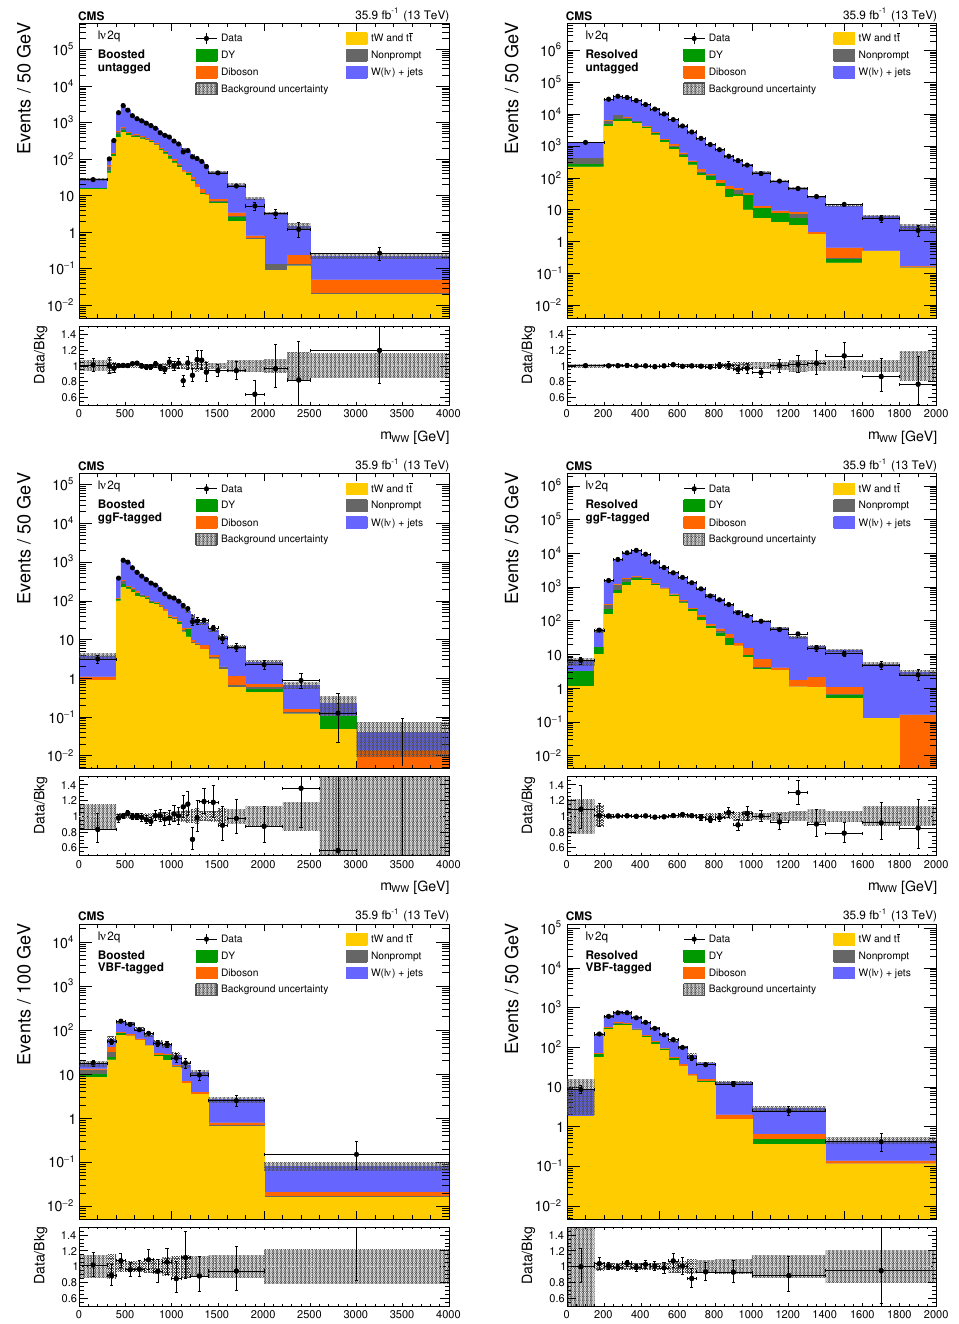
Figure 5 . The m distributions in the sideband control regions of the ‘(cid:23) 2q boosted (left) WW and resolved (right) categories, after (cid:12)tting the sideband data with the top quark background normalization determined using a control region. Electron and muon channels are combined. The points represent the data and the stacked histograms show the expected backgrounds. The hatched area shows the combined statistical and systematic uncertainties in the background estimation. Lower panels show the ratio of data to expected background. Larger bin widths are used at higher m ; the bin widths are indicated by the horizontal error WW